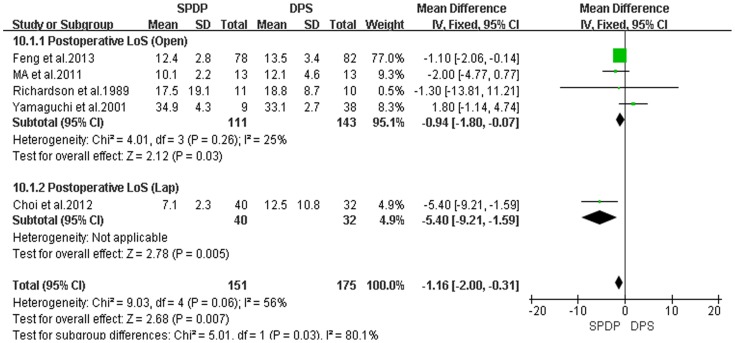
Postoperative LoS (days) (IV, Inverse variance; M-H, Mantel-Haenszel; CI, Confidence Interval; SD, standard deviation).